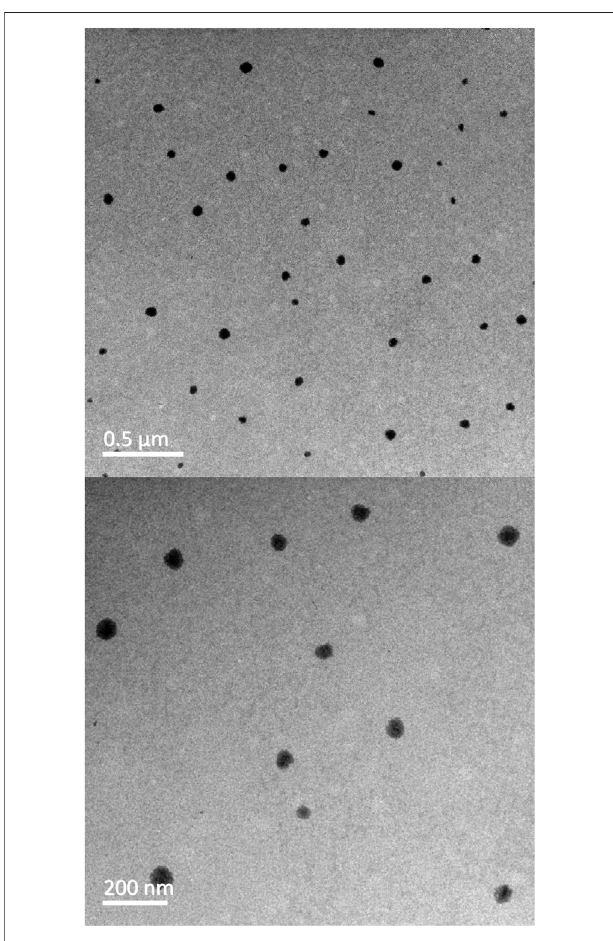
FIGURE 6 | Transmission electron micrographs of LFs microemulsion.